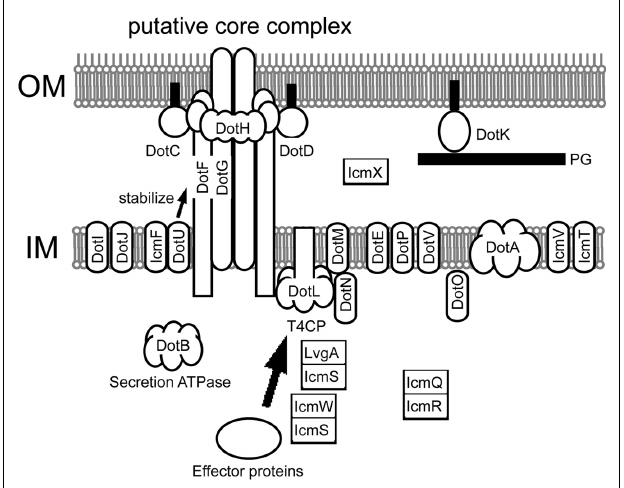
FIGURE 3 | Legionella pneumophila Dot/IcmT4BSS. The putative core complex containing DotC, DotD, DotH, DotG, and DotF was suggested by Vincent et al. (2006b). A possible scenario of its assembly is as follows: (1) outer membrane lipoproteins DotC and DotD recruit intrinsic periplasmic protein DotH to the outer membrane, thus forming a DotC–DotD–DotH outer membrane complex; (2) the C-terminal domain of DotG participates in the outer membrane complex, resulting in a complex spanning both inner and outer membranes; and (3) DotF participates in the core complex by binding to DotG and/or the DotC–DotD–DotH complex. Subcellular localization of Dot/Icm proteins are depicted based on lines of experimental evidence (Roy and Isberg, 1997; Zuckman et al., 1999; Coers et al., 2000; Matthews and Roy, 2000; Sexton et al., 2004a,2004b;Vincent et al., 2006b), or prediction from amino acid sequences (DotE, DotJ, DotV, and IcmT).